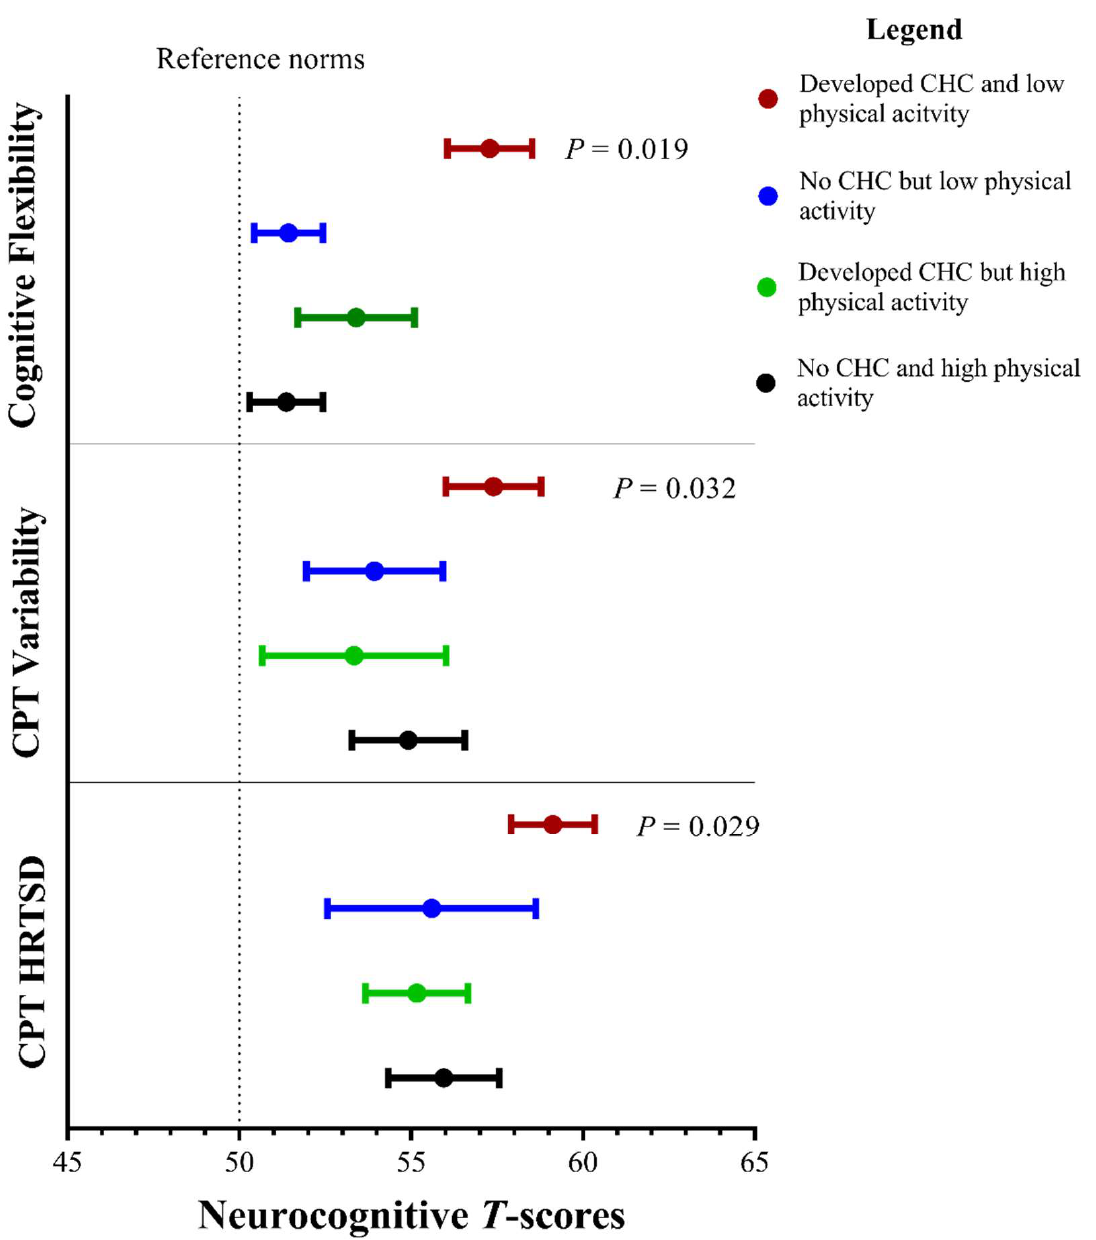
Figure 2. Interaction between chronic health conditions and physical activity. CHC: chronic health conditions; HRTSD: hit reaction time standard deviation. High physical activity refers to survivors who reported a score of ≥ 7 points on the CUHK-PARCY, which corresponds to the World Health Organization recommended ≥ 150 min of moderate-intensity aerobic physical activity per week. There was significant interaction for CHCs*physical activity for cognitive flexibility ( p = 0.019), CPT variability ( p = 0.032) and HRTSD ( p = 0.029). This suggests that survivors who developed CHCs and reported low physical activity demonstrated the worst cognitive flexibility and attention outcomes, as compared to survivors in other subgroups.